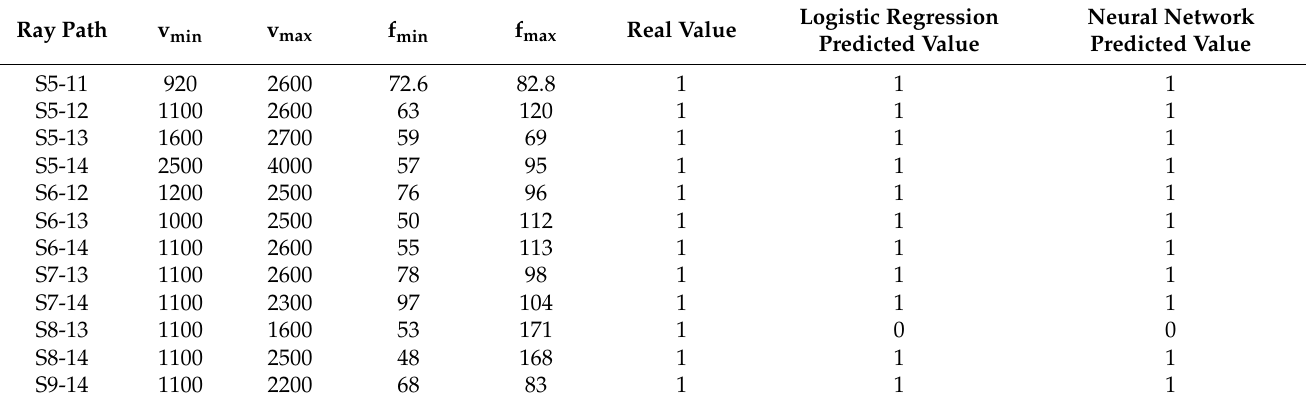
Table 1. Prediction results of logistic regression and neural network.